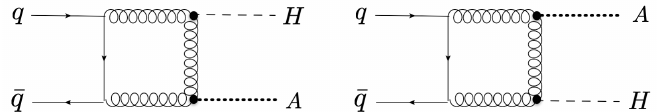
Figure 4: Diagrams contributing to the right-hand side of (17). The blobs denote the effective vertex.